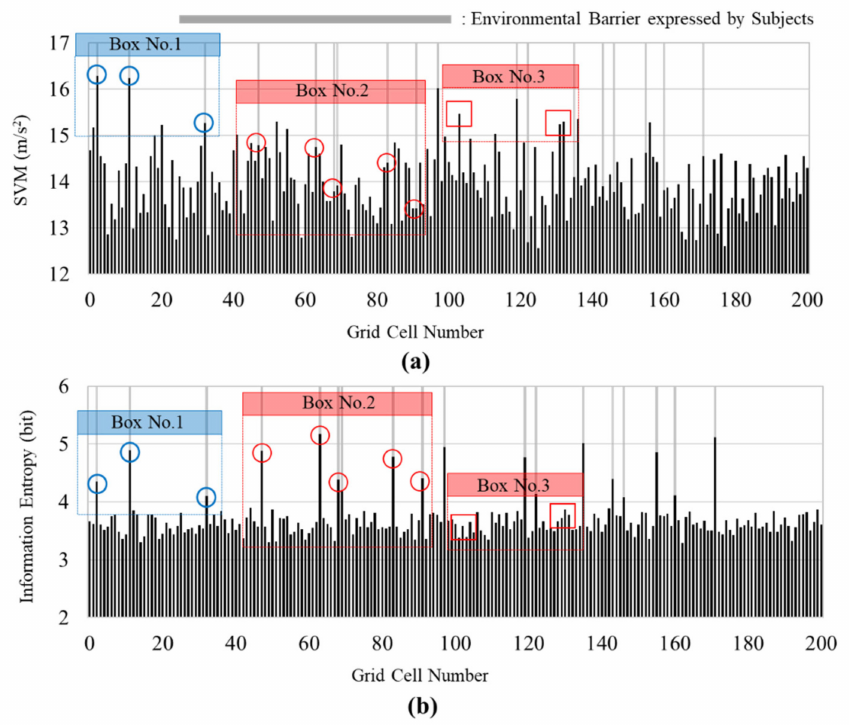
Figure 3. Calculation results: ( a ) Average of SVM values; and ( b ) Information entropy